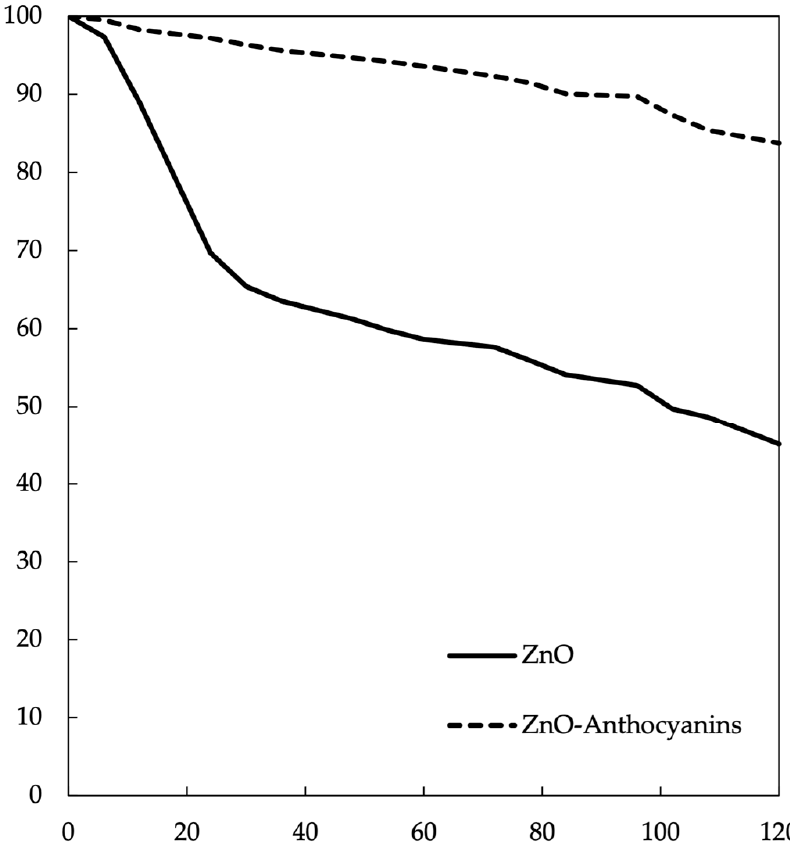
Figure 4. The maximal concentration of Zn 2+ was quantified by digesting 10 mg of ZnO or ZnO– anthocyanin in HNO 3 (concentrated) for 2 h and measuring the concentration of Zn 2+ by AAS. The Zn 2+ concentration was calculated using a calibration curve prepared previously (Figure S1) and the measures were performed at pH 7 and at room